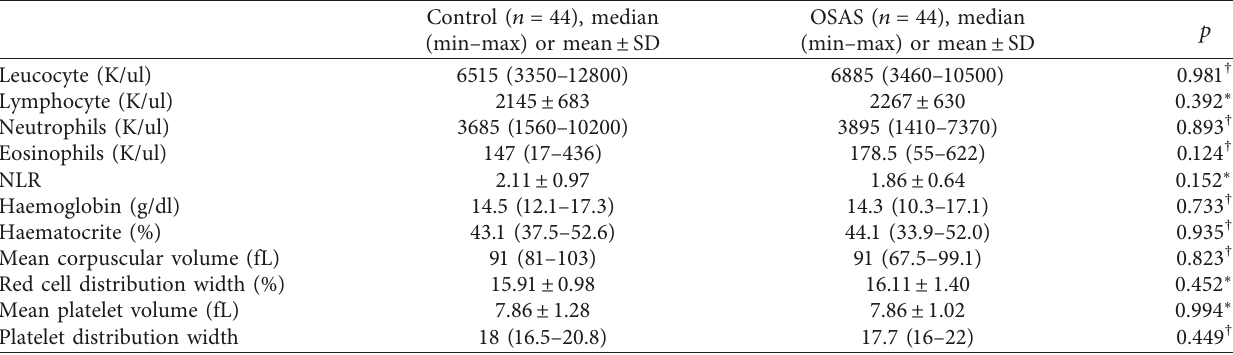
Table 2: Hematologic parameters of the groups.